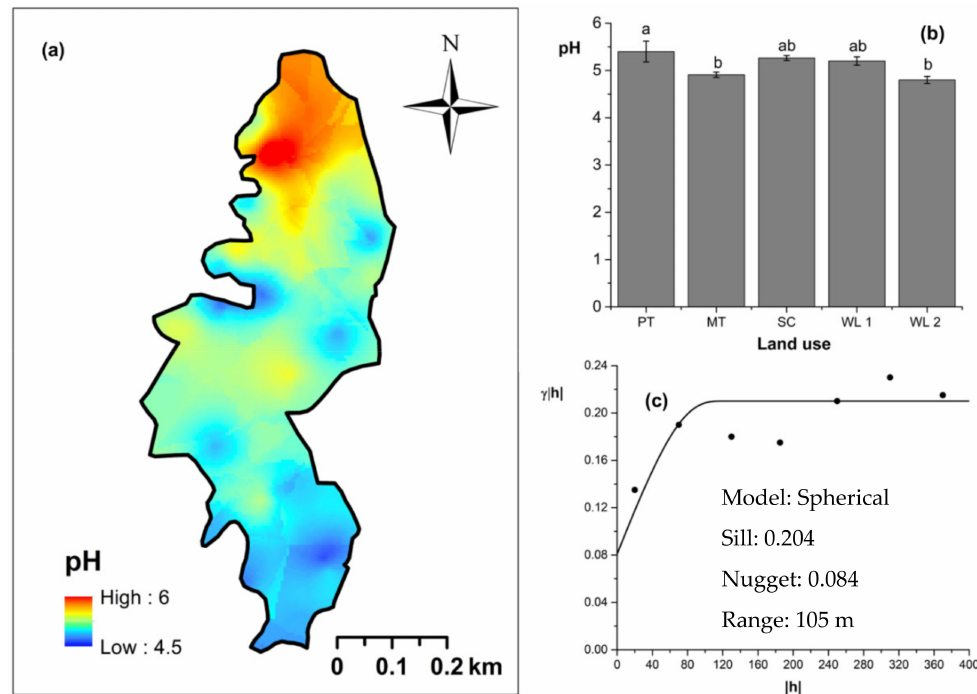
Figure 8. Spatial variability of soil pH: ( a ) map, ( b ) bar graph among different land uses (see Figure 1, label A for notations) in the Endane Biodiversity Corridor, and ( c ) variogram between lag distance and semivariance. Semivariance function: γ ( h ) = 0.088 + 0.0029 h − 8.811 × 10 − 8 h 3 . Comparisons depicted by the different letters on the bars in subfigure ( b ) indicate significant pair-wise